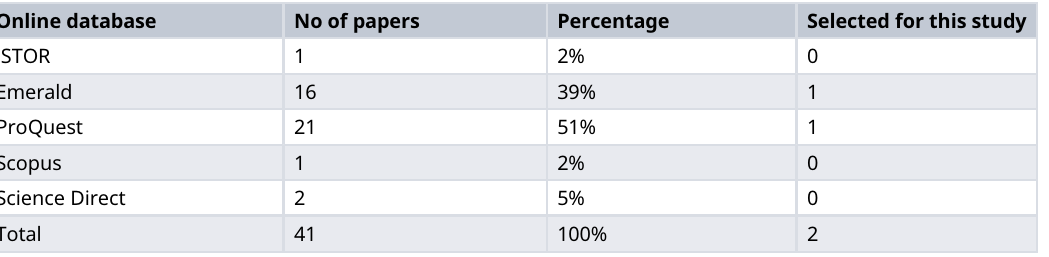
Table 2. Source of 41 Papers.